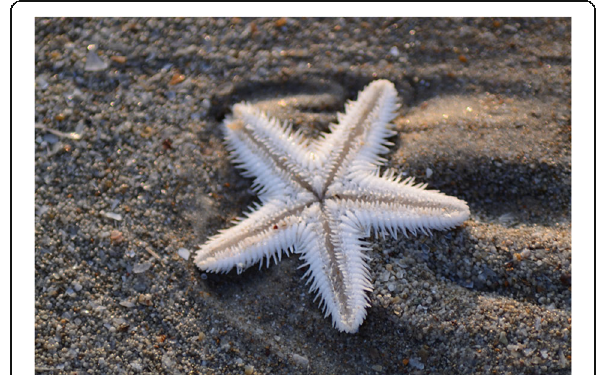
Fig. 1 Astropecten indicus found along the coast of Goa, India. Picture of Asteropecten indicus found in Goa, India. The sea-star was identified as Astropecten indicus by the Zoological Survey of India, Chennai,